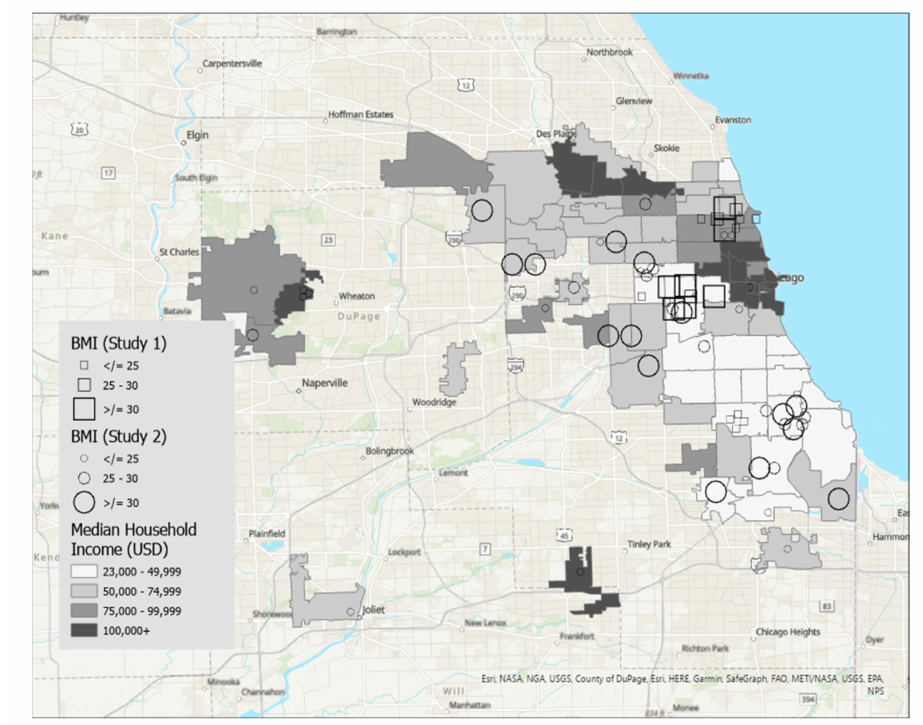
Figure 3. This figure displays BMI overlaid on a map of median income. Participants with the highest BMI tend to live in zip codes with lower median income. Similarly, participants with lower BMIs were dispersed across zip codes with varying levels of median